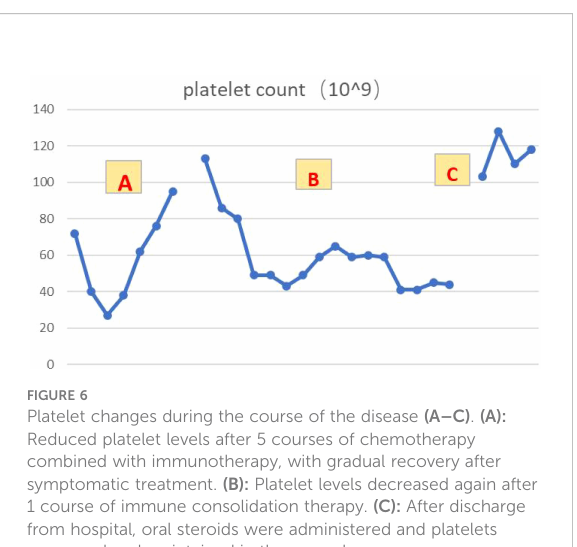
from hospital, oral steroids were administered and platelets recovered and maintained in the normal range.